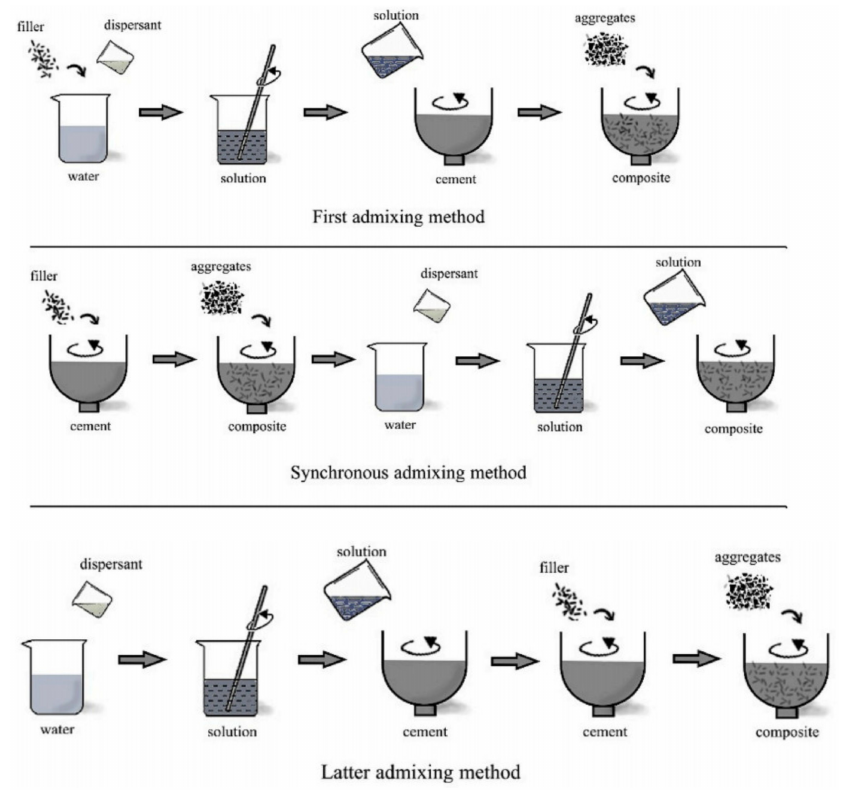
Figure 1. Three mixing procedures. Reproduced with permission from [34], Elsevier,